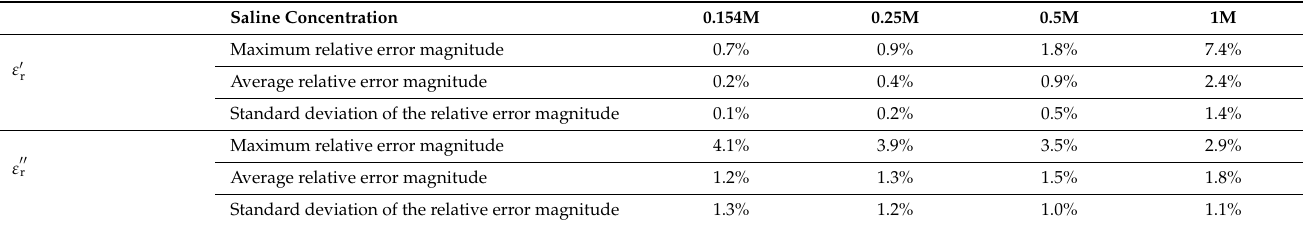
Table 4. FEKO simulation study—relative